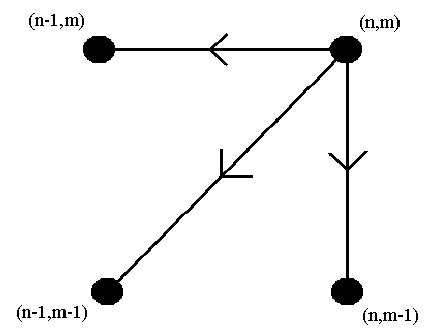
Figure 9. Three possible directions for constructing each step of the path.